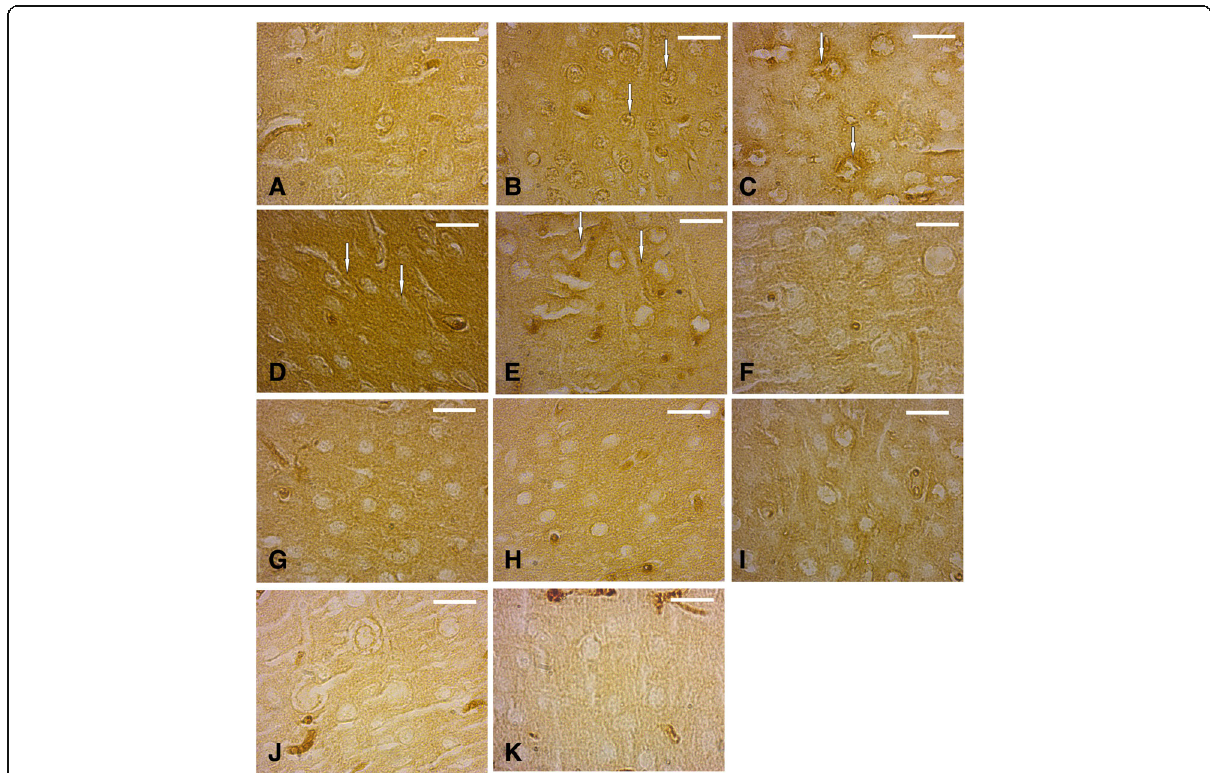
Fig. 9 Photomicrographs of immunohistochemistry of α -synuclein in neurons and the glia of the cerebral cortex of the control group ( a ). The acrylamide-administrated groups showed increase in expression at 30 and 45 days and more denser at 60 days of administration (arrows, b – d ), respectively. The chips feeding group (arrows, e ) showed increased expression of α -synuclein. The BV- and BPF-treated groups ( f , g ) at 60 days showed α -synuclein expression similar to the control. The acrylamide-administrated groups treated with either BV ( h ) or BPF ( i ) showing downregulated expression of α -synuclein compared to acrylamide administration. The chips feeding groups treated with either BV ( j ) or BPF ( k ) showing the normal expression and distribution of staining that was mostly similar to the control. Immunostaining of α -synuclein; scale bar 5 μ